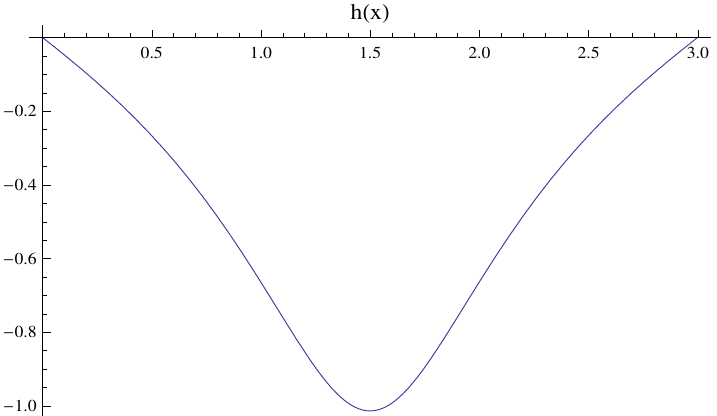
Figure A1. Plot of ln | ψ | in a symmetric solution with ∆ ϕ (cid:39) 2.9, L = 3.